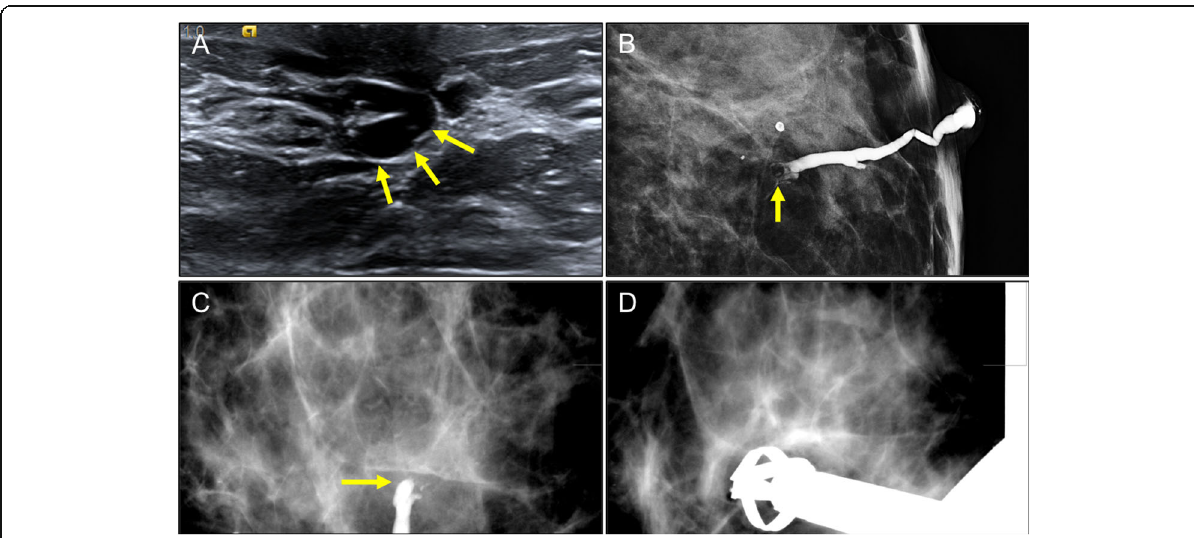
Fig. 17 Galactography-guided percutaneous excision biopsy. A 59-year-old woman with a 1-week history of serous discharge from a single orifice in her right nipple. a Ultrasound shows retroareolar ductal ectasia without apparent intraductal lesions (arrows). b Craniocaudal ductogram shows a concave cutoff situated 2.5 cm behind the nipple. c Image of the lesion at the level of the cutoff obtained with the patient positioned prone on the stereotactic table. d The lesion was excised with the Intact-BLES ™ biopsy system (Medtronic Inc., Dublin, Ireland). Histology diagnosed intraductal papilloma